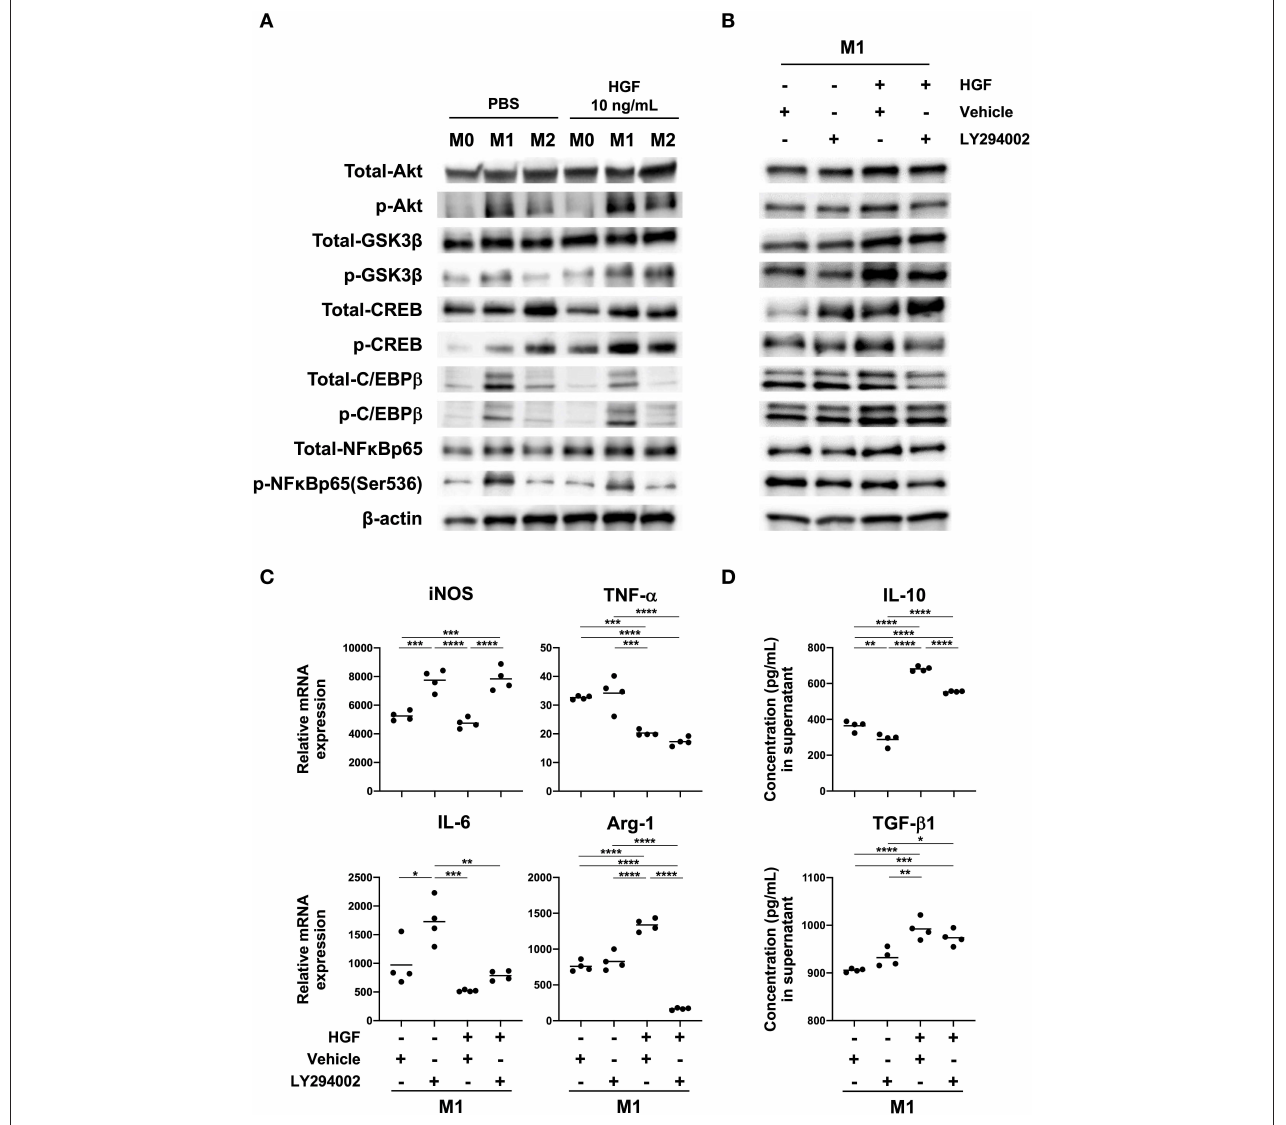
FIGURE 3 | HGF-MET signaling induces PI3K-mediated Arg-1 expression. (A) Effect of HGF treatment on activity of the PI3K pathway in macrophages. Bone marrow-derived macrophages (BMDMs; M0 macrophages) were induced through the treatment of bone-marrow cells with M-CSF (25ng/mL) for 7 days. Macrophages were polarized to M1 and M2 phenotypes with treatment for 48h using IFN- γ and LPS or IL-4, respectively. Western blotting was used to analyze the levels of total and phosphorylated Akt, GSK-3 β , CREB, C/EBP β , and NF- κ B. (B) Effects of HGF treatment on downstream PI3K signaling in the presence and absence of PI3K inhibitor. M1 macrophages were treated with a PI3K inhibitor (LY294002) for 1h after PBS or HGF treatment for 24h. Western blotting was used to analyze the levels of total and phosphorylated Akt, GSK-3 β , CREB, C/EBP β , and NF- κ B. β -actin was used as a loading control. (C) Effect of PI3K inhibitor treatment on the expression of M1 and M2 markers with or without HGF treatment. RT-qPCR was used to compare mRNA expression of iNOS , TNF- α , IL-6 , and Arg-1 in M1 macrophages that were treated with or without PI3K inhibitor and HGF for 24h. The Ct values were normalized to those of β -actin and are expressed relative to mean levels in M0 macrophages not treated with HGF, which is arbitrarily defined as 1. (D) ELISA was used to measure the secretion of IL-10 and TGF- β 1 . Data are represented as the mean and a scatterplot showing individual data points ( n = 4). One-way ANOVA, * P < 0.05, ** P < 0.01, *** P < 0.001, and **** P <